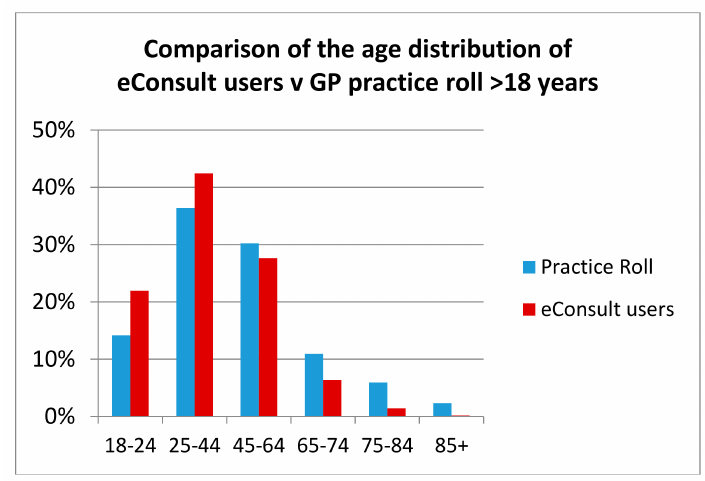
Figure 6. Comparison of the relative age distribution of patients aged over 18 with the age distribution of eConsult users in the trial practices (excluding P04, P06 and P07).